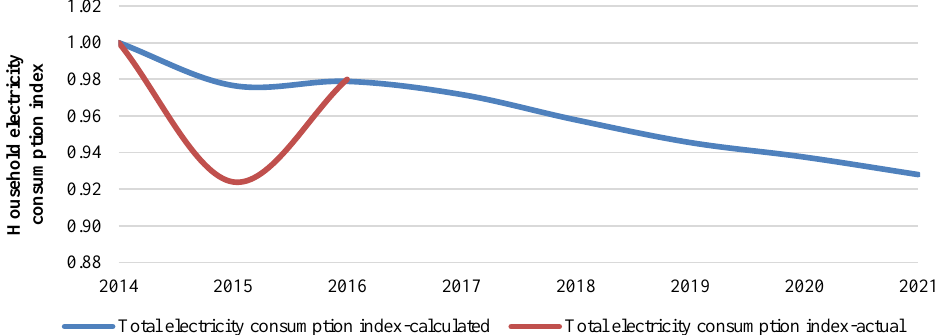
Fig. 8. Total household electricity consumption index – calculated results and actual data (the initial consumption: 1887 GWh/year). The calculated and the actual indexes coincide during the year 2016 and the results of the model indicate further decline in electricity consumption, starting with the year 2016. As will be discussed in more detail in the “Results and Discussion” chapter below, this can be explained by the rate of increase of energy efficiency of technologies being larger than the rate of increase of demand for the energy services.